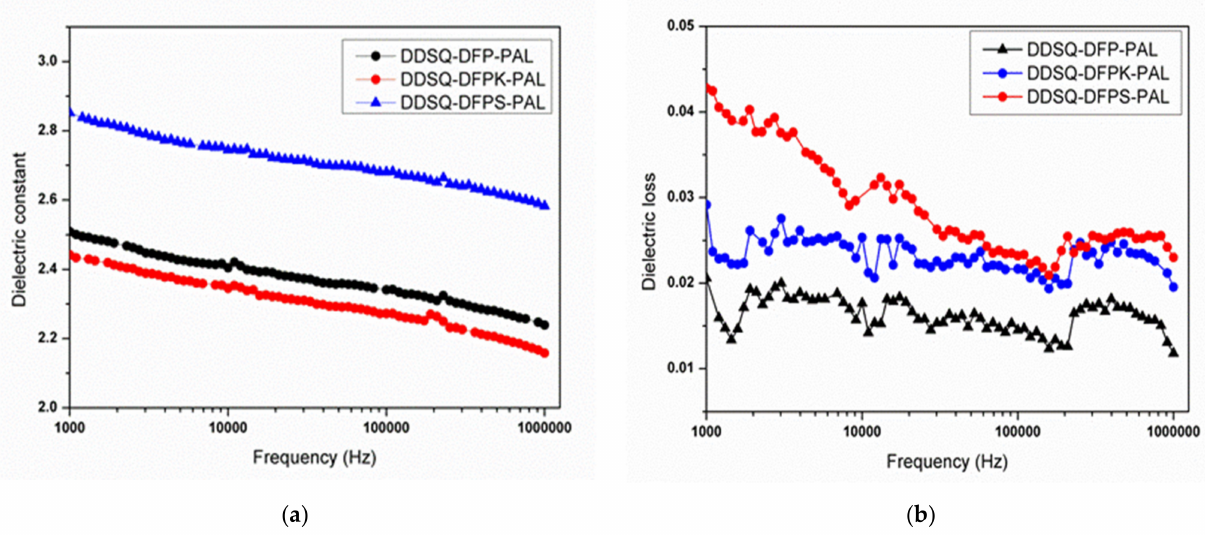
Figure 10. ( a ) Dielectric constant spectra of DDSQ-DFPXs-PAL films after curing; ( b ) dielectric loss spectra of DDSQ-DFPXs films after